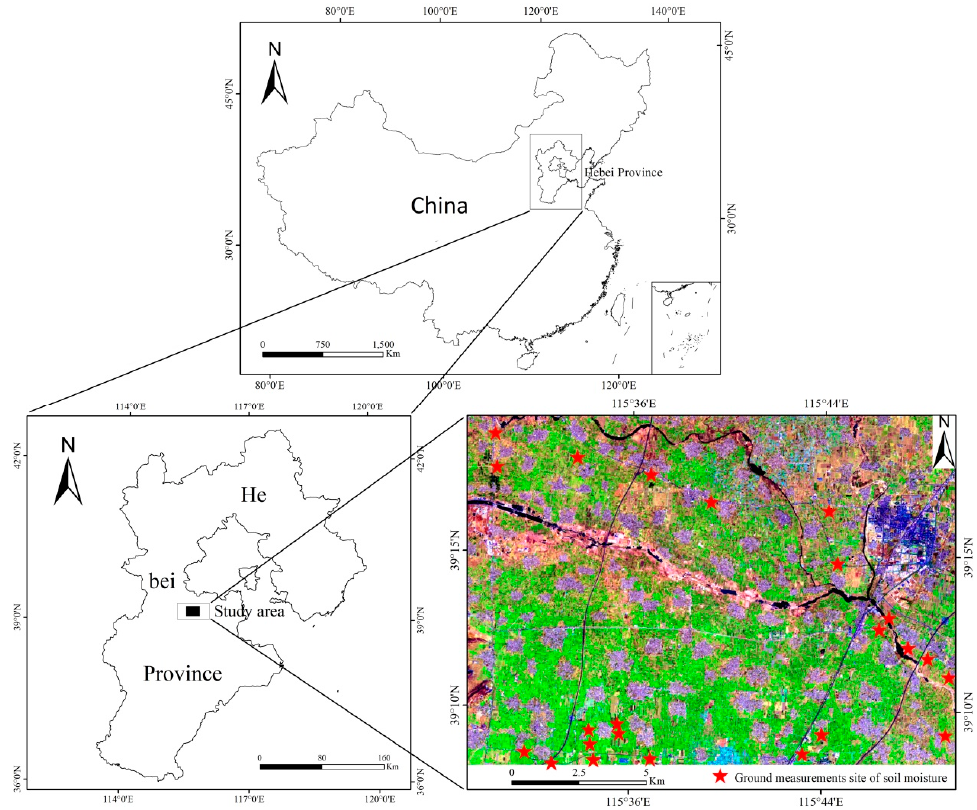
Figure 1. Location of the study area and the ground measured sites.